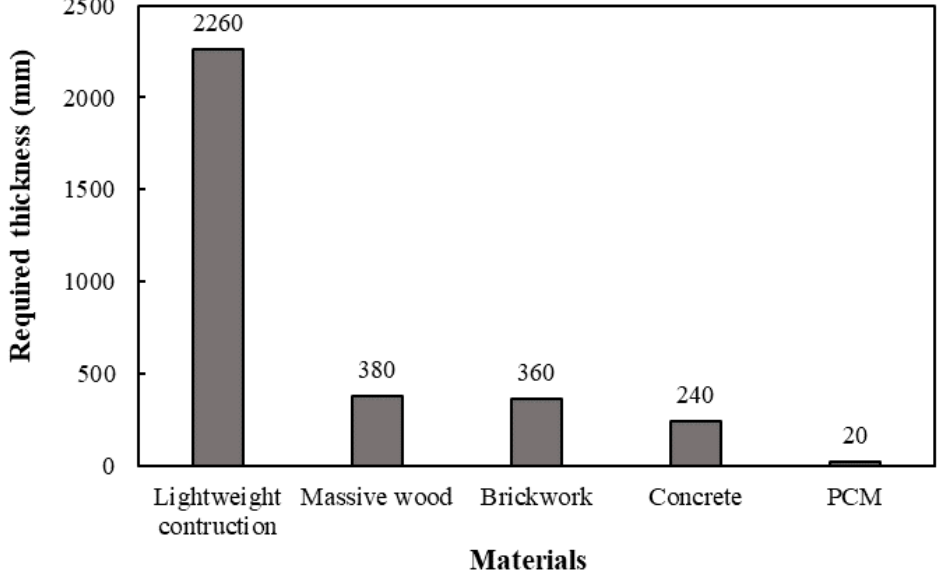
Figure 3. The thickness of building materials required to store the same amount of energy [17]. PCMs are divided into organic materials, such as paraffin and non-paraffin-based compounds, inorganic materials, such as hydrated salts and metallics, and eutectics [18], which are a mixture of components with a freezing point less than the individual compo- nents. Figure 4 illustrates the classification of the PCMs [19]. All PCM types have some advantages and disadvantages [20] which are summarized in Table 1.